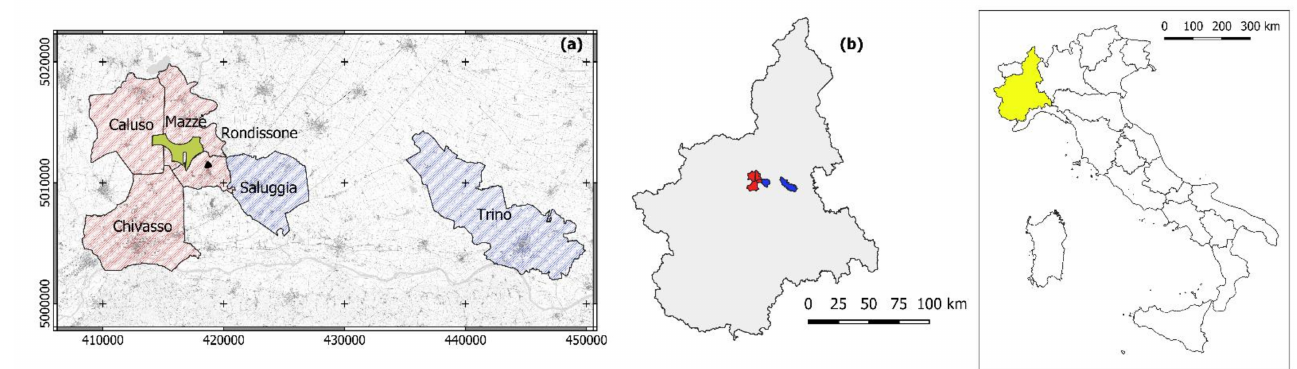
Figure 1. Location of the study area within the Piemonte Region and Italy ( b ). In ( a ) the administrative boundaries of the involved municipalities (Mazz è , Caluso, Rondissone, Chivasso, Trino, Saluggia) are reported together with the TO-10 area. In blue, the Saluggia and Trino municipalities presently hosting radioactivity-related facilities. Reference system is WGS84 UTM